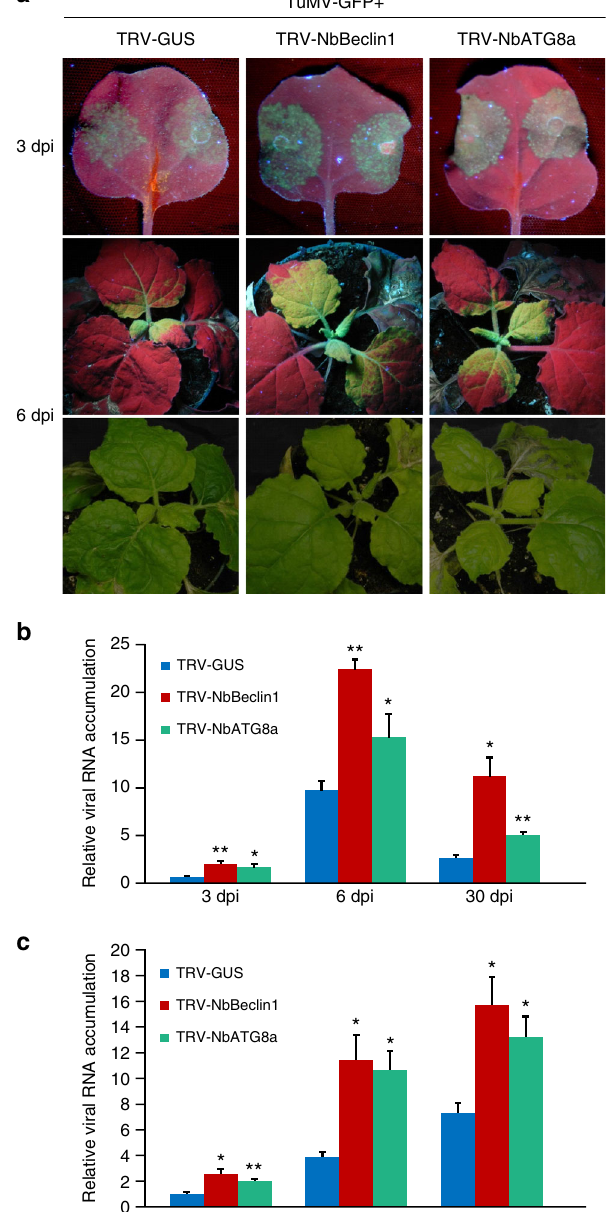
Fig. 8 Silencing of NbBeclin1 or NbATG8a promotes TuMV infection in N . benthamiana . a GFP fl uorescence and viral symptoms in plants pre- inoculated with TRV1 together with TRV2-GUS (control), TRV2-NbBeclin1, or TRV2-NbATG8a for 7 days and then infected by TuMV-GFP. Plants were photographed under UV light at 3 and 6 dpi and under regular light at 6 dpi. b Quanti fi cation of TuMV genomic RNA in the above plants. RNA was extracted from TuMV-GFP-inoculated leaves at 3 dpi or systemically infected leaves at 6 dpi and 30 dpi. The values are presented as means of fold change ±SD relative to the control plants (pretreated with TVR1 and TRV2-GUS). Error bars represent SD. Three independent experiments, each consisting of three biological replicates, were carried out. Values from one representative result were used to plot a histogram and were normalized against NbActin transcripts in the same sample. The data were analyzed using Student ’ s t -test (two-sided, * P < 0.05, ** P < 0.01). c Protoplast transfection assay. Protoplasts isolated from N . benthamiana plants pre- inoculated with TRV1 together with TRV2-GUS, TRV2-NbBeclin1, or TRV2- NbATG8a were transfected with TuMV-GFP. RNA was extracted at 16, 24, and 48 hpt and quanti fi ed by qRT-PCR to analyze TuMV genomic RNA accumulations. Values are presented as means ± SD, and error bars represent SD ( n = 3 biological replicates). The data were analyzed using Student ’ s t -test and asterisks denote signi fi cant differences compared to the TuMV-infected protoplasts from control plants pre-treated with TRV1 and TRV-GUS (two-sided, * P < 0.05, ** P <